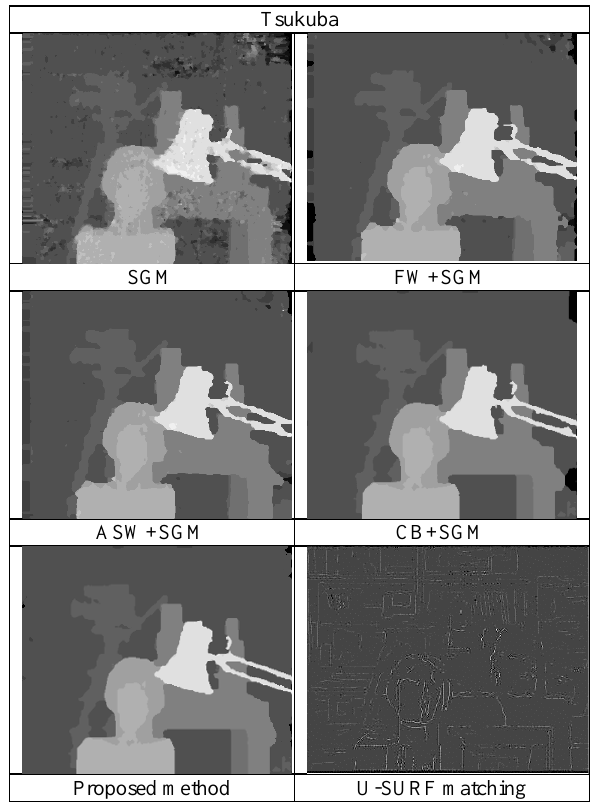
Table 3. The resultant disparity